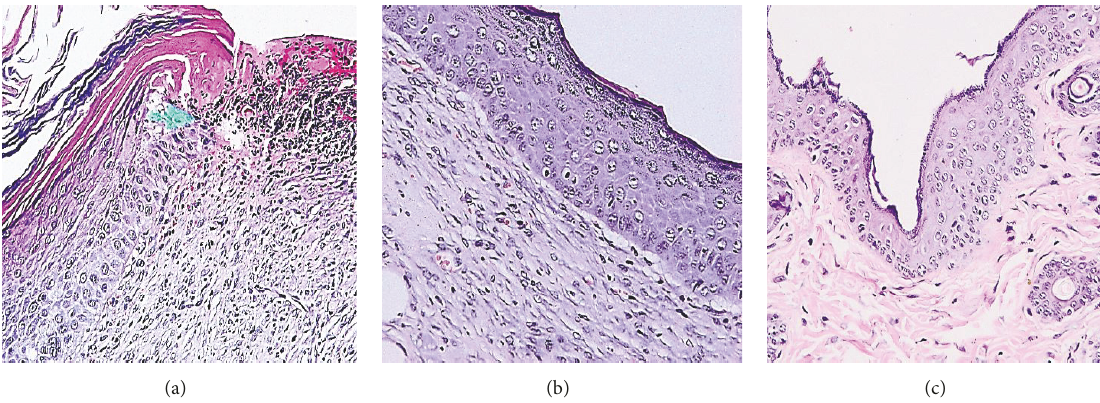
Figure 5: Microscopic changes in burn wounds of experimental mice . Histology studies revealed that burn wounds treated with essential oil developed complete epidermal structure (c). In tamanu oil treated mice, wounds were partially recovered with existence of coagulative necrosis region on epidermis and vascular congestion, swollen stromal tissue, and no matured hair follicles (b). On the contrary, saline treated mice formed uneven epidermal layer with the ulcer on epidermis layer and infiltration of immune cells (a). The highlighted part in (a) pointed out the ulcer region with infiltration of lymphocytes and multinuclear